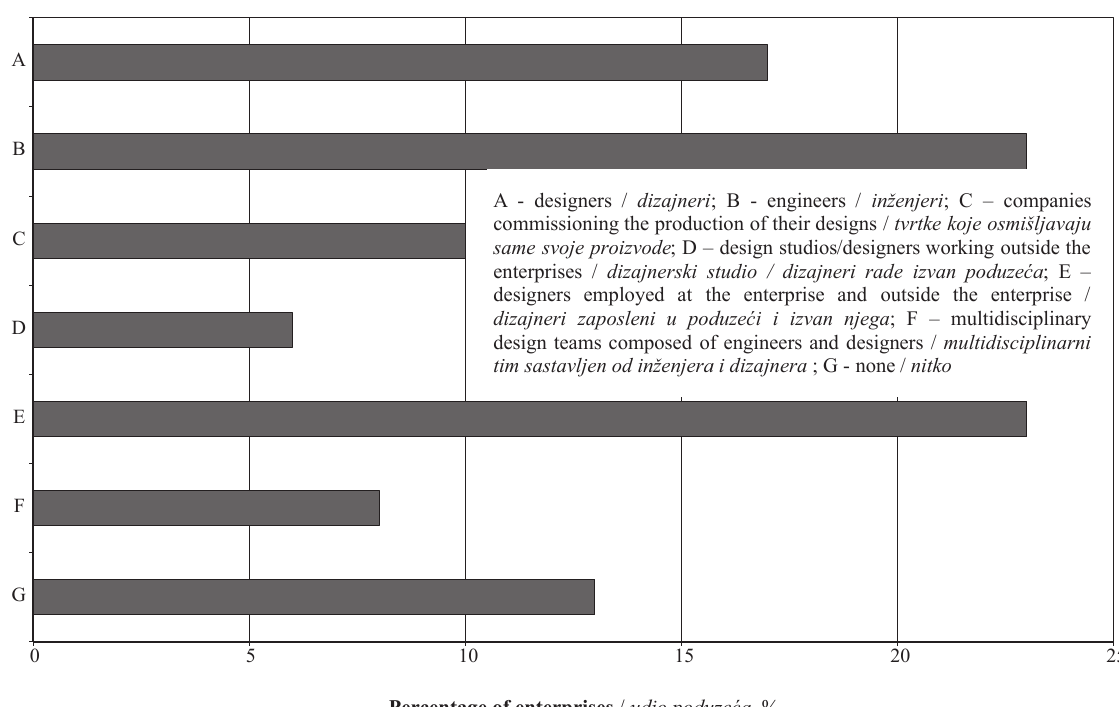
Figure 4 Structure of analysed furniture enterprises depending on the type of design activity the enterprise plans to develop within 3 years since the period of the study Slika 4 . Struktura analiziranih tvrtki za proizvodnju namještaja ovisno o aktivnostima dizajniranja proizvoda koje tvrtka planira pokrenuti unutar tri godine od provedenog